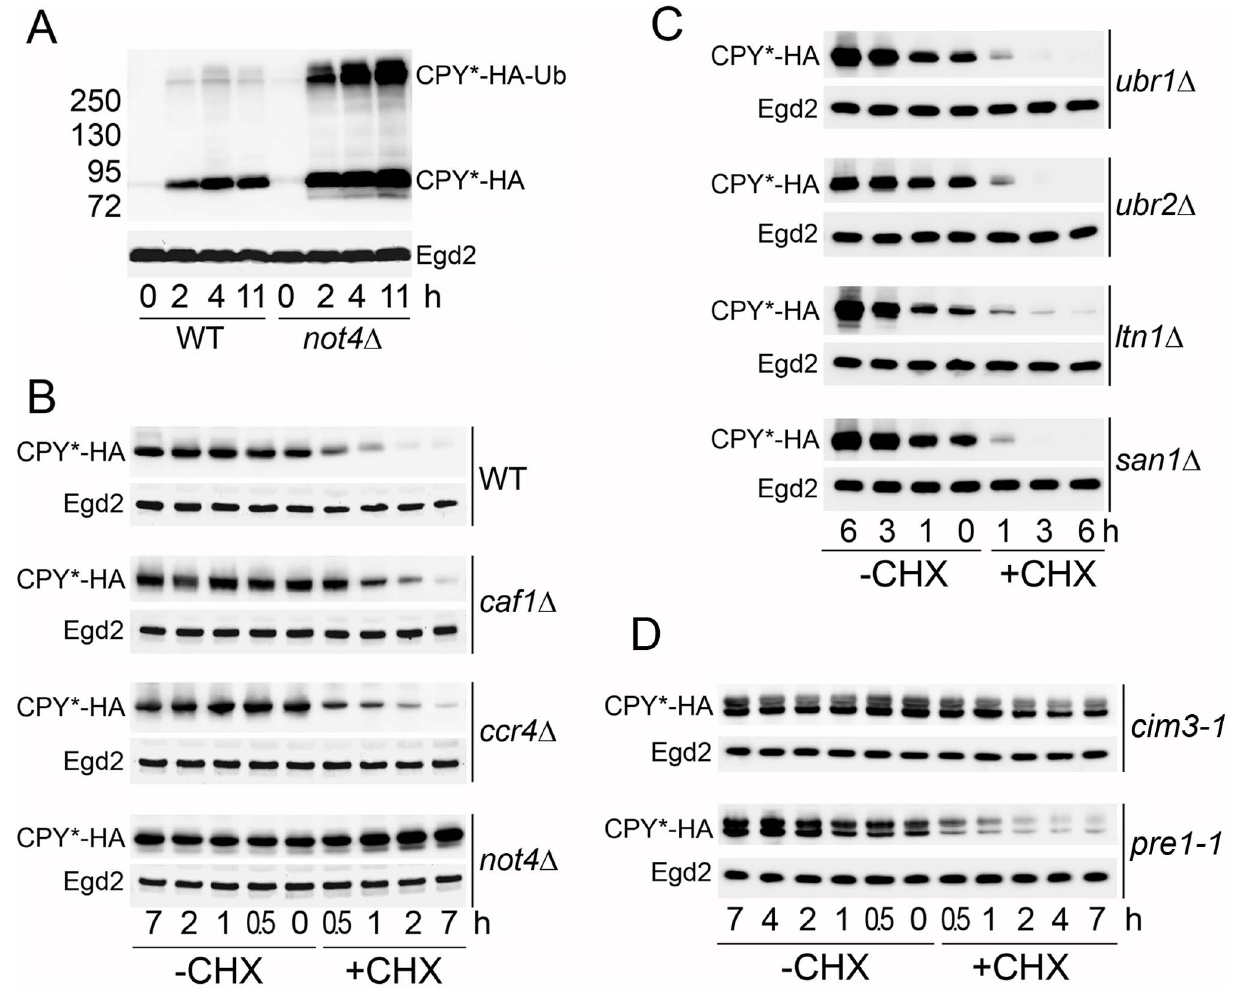
Figure 4. The deletion of Not4, but not the deletion of the deadenylase, stabilizes the proteasomal substrate CPY*. A. CPY*-HA was expressed from an episome under control of a copper dependent promoter in wild-type (WT) and not4 D cells. Cells were exponentially grown without induction to OD 600 of 0.6 (time 0). 0.1 mM CuSO 4 was added to the media and cells were collected at indicated time points (2, 4 and 11 h) and analyzed by SDS-PAGE and western blot with antibodies against HA, to see CPY*-HA levels, and against Egd2 as a loading control. The positions of CPY*-HA and ubiquitinated CPY*-HA (CPY*-HA-Ub) are indicated on the right. The molecular weight markers are indicated on the left. B. Stability of CPY*-HA was analyzed in wild-type, caf1 D , ccr4 D , and not4 D cells. Cells were grown exponentially and treated ( + CHX) or not ( 2 CHX) with CHX. Samples were collected at indicated time points and analyzed as in A. Since CPY*-HA expression was different in mutant strains (see Fig. S2A) 2 times less material was loaded on the gel in the case of not4 D samples compared to wild type, and 4 times less material was loaded on the gel in the case of the ccr4 D and caf1 D samples compared to wild type. C. Stability of CPY*-HA was analyzed in ubr1 D , ubr2 D , ltn1 D , and san1 D cells as in B. D. Stability of CPY*-HA was analyzed in cim3-1 and pre1-1 cells as in